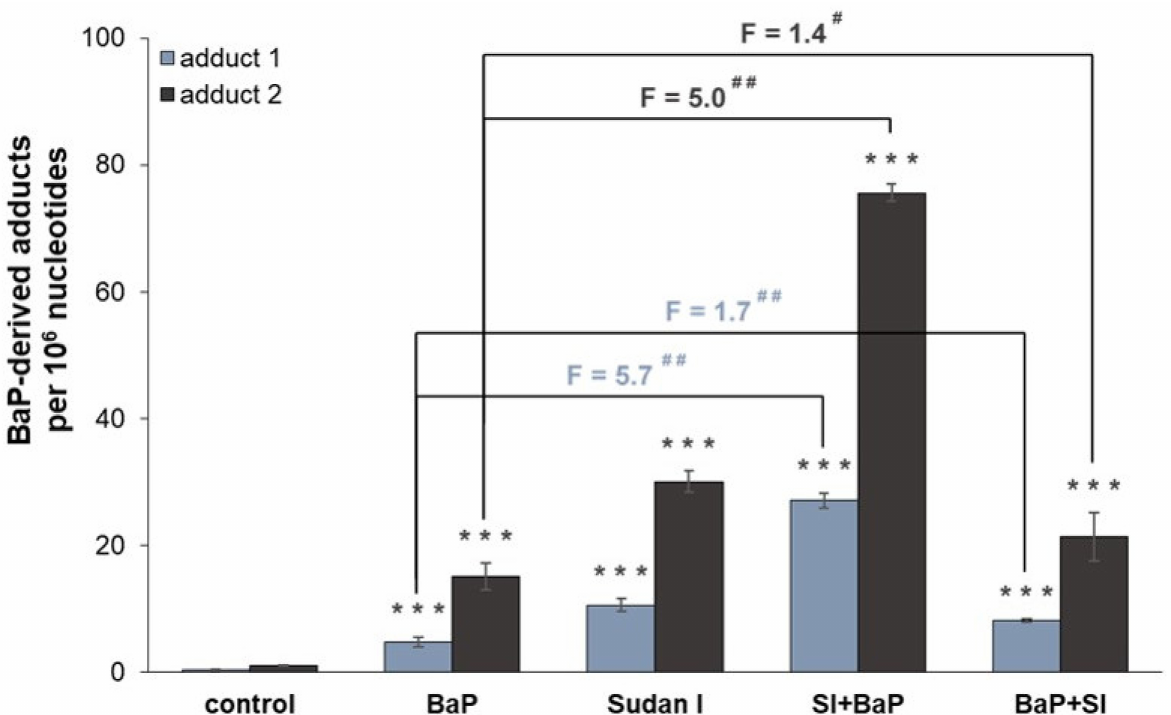
Figure 4. DNA adduct formation by BaP, measured by TLC- 32 P-postlabelling, after activation with hepatic microsomes isolated from livers of control (untreated) rats and rats exposed to BaP alone, Sudan I alone, Sudan I before BaP treatment (SI + BaP) or Sudan I after BaP treatment (BaP + SI). The levels of BaP-derived adducts were related to 1 nmol of total microsomal CYP in the incubation. Numbers above columns (“F”) indicate fold changes in DNA adduct level in comparison to incubations with microsomes from animals treated with BaP alone. The values represent mean ± S.D. of three independent incubations. Statistical comparison was performed by t -test analysis: # p < 0.05, ## p < 0.01—results significantly different from incubations with microsomes of rats treated with BaP alone; *** p < 0.001—significantly different from incubations with microsomes of control rats. Adduct 1—dG- N 2 -BPDE; adduct 2—9-hydroxy-BaP-4,5-epoxide-derived guanine